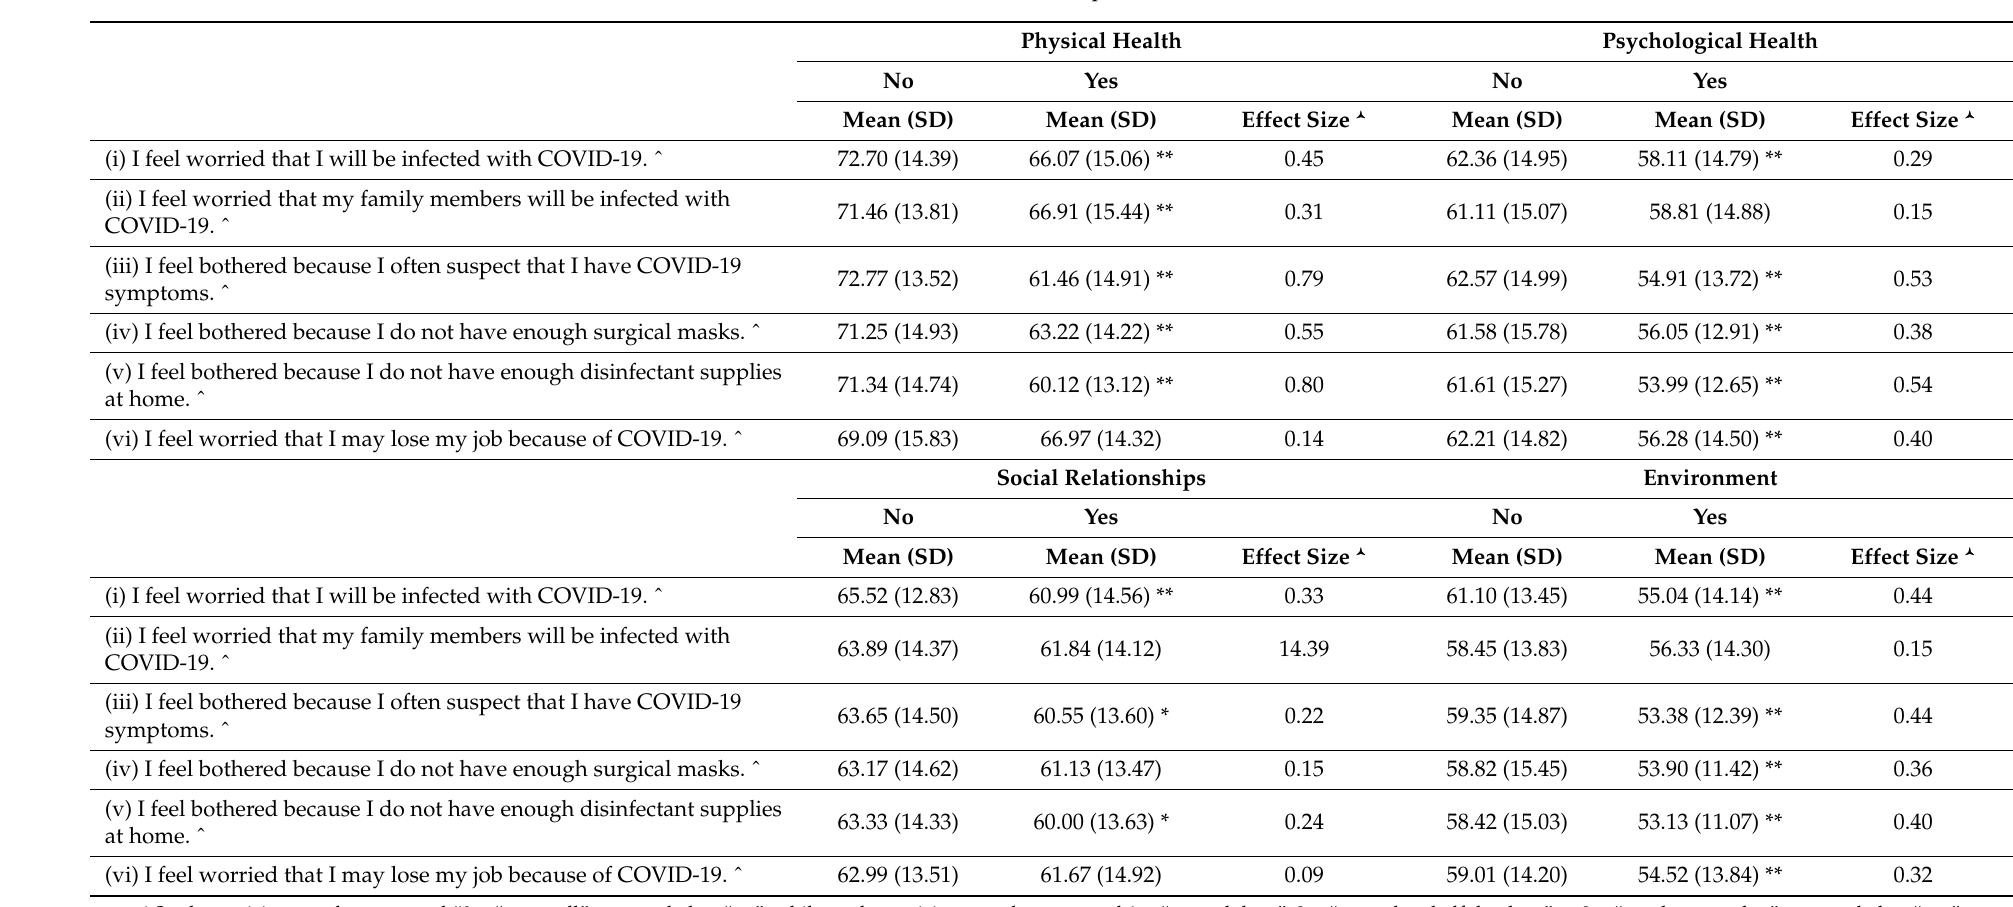
Table 2. Results of independent t -tests.